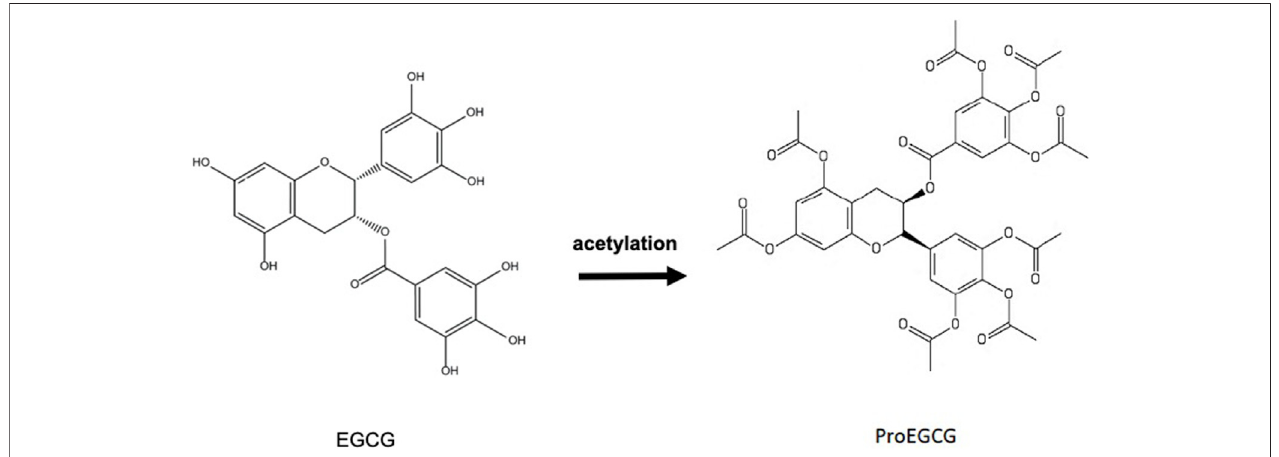
FIGURE 3 | Chemical synthesis of ProEGCG from